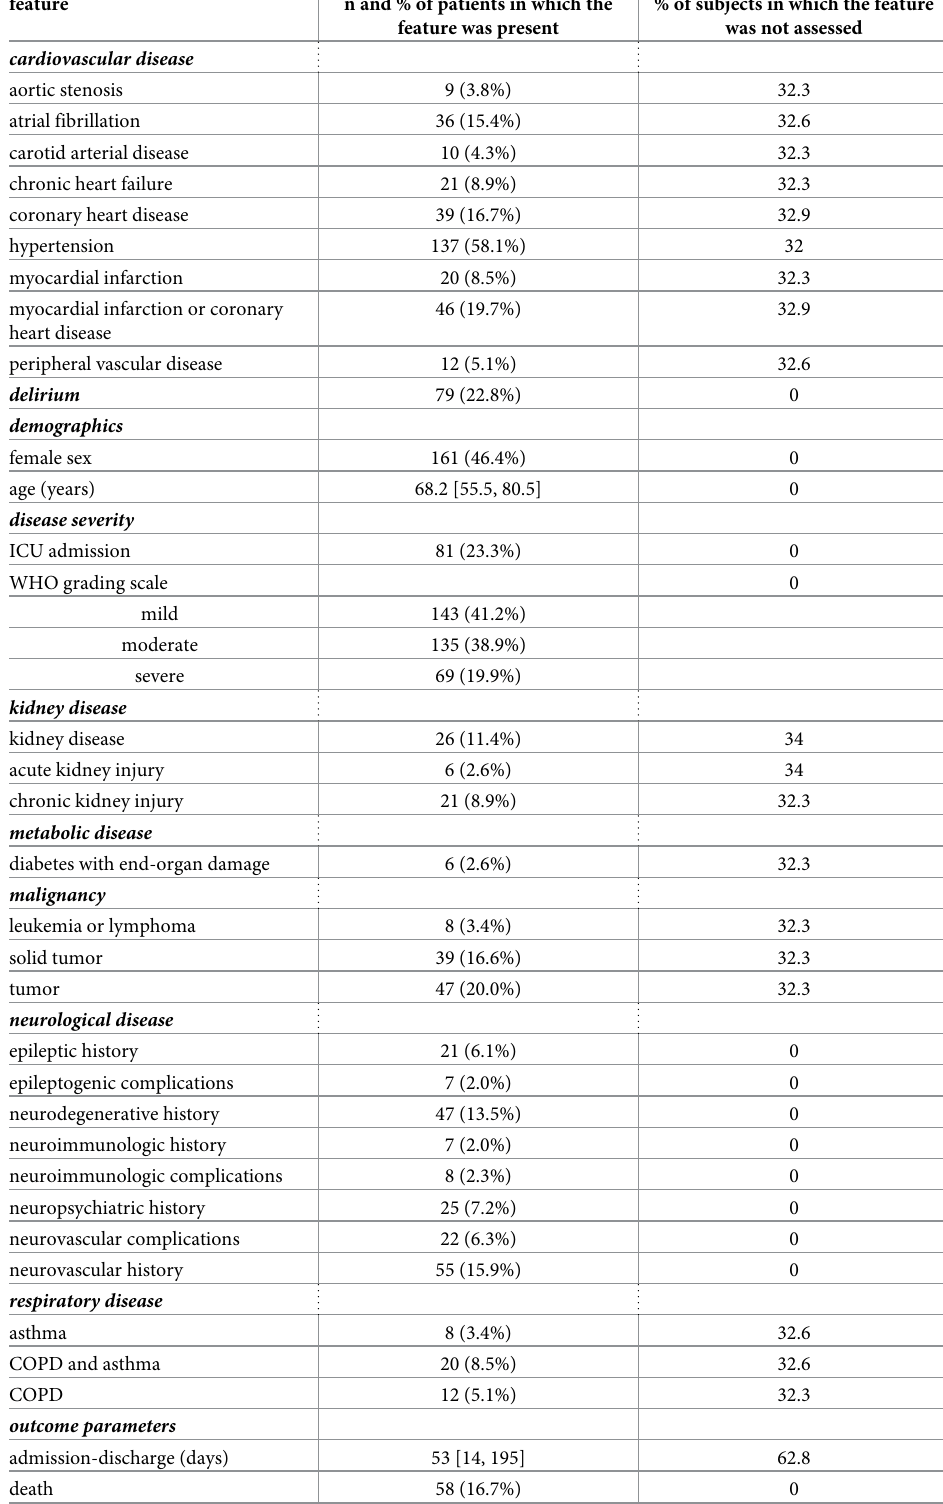
Table 1. Overall clinical and laboratory characteristics of the study